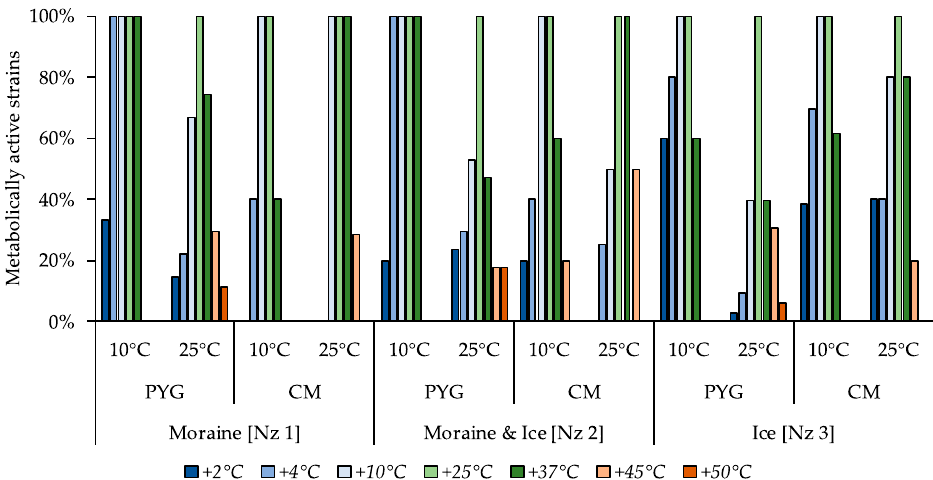
Figure 6. Isolated strains’ resistance to cultivation temperature. Vertical axis: proportion of the strains in the culturable community able to reproduce in considered conditions. Horizontal axis: the tested communities. Temperature and medium abbreviations indicate the isolation conditions. PYG and CM—peptone yeast glucose and modified Czapek media, respectively.